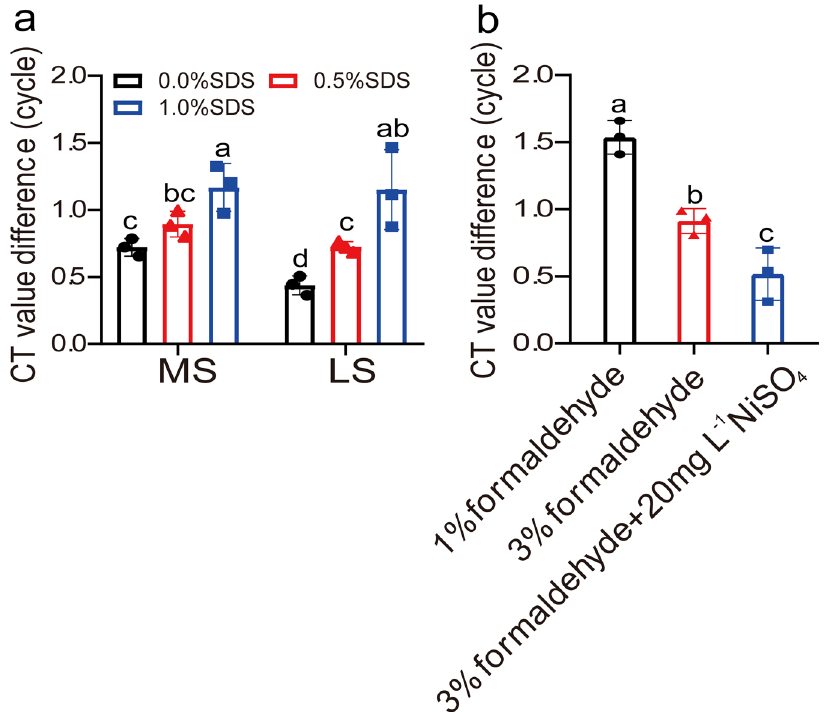
Fig. 3 Analysis of the effects of different hybridization buffers and cross-linking methods on decross-linking of chromatin. a Analysis of the effects of SDS concentration and different buffers on decross-linking of chromatin. MS and LS hybridization buffer [containing 10% (v/v) formamide supplied with 0, 0.5%, and 1% (w/v) SDS] were used in hybridization at 37 °C for 4 h. To analyze decross-linking, the chromatin was cross-linked with 3% (w/v) formaldehyde, and treated at 90 °C for 2 min for denaturation before hybridization. b Analysis of the effects of different crosslinking methods on preventing decross-linking of chromatin during heat and hybridization. The chromatin was cross-linked with 1%, 3%, or 3% (w/v) formaldehyde supplement with 20 mg L − 1 NiSO 4 , and incubated in LS buffer [with 10% (v/v) formamide, 0.5% (w/v) SDS] at 90 °C for 2 min to denature the chromatin, and then hybridized for 4 h. After heating and hybridization, the decross-linked DNA was quanti fi ed using qPCR. The y -axis indicates the CT value difference (i.e., Δ Ct), Δ Ct = Ct (decross-linked DNA before heat) − Ct (decross-linked DNA after hybridization). Increased Δ Ct value indicates increased decross-linking of DNA and protein. Three replicates (sample size of 50 seedlings) were performed ( n = 3 independent experiments). Error bar indicates standard deviations of the mean measurements. Multiple comparisons of means were performed using Tukey ’ s test, and different letters represent signi fi cant differences among treatments ( P < 0.05). The promoter region of AtCAT3 used for the qPCR evaluation was site 1 and is shown in Fig. 7l and Supplementary Data